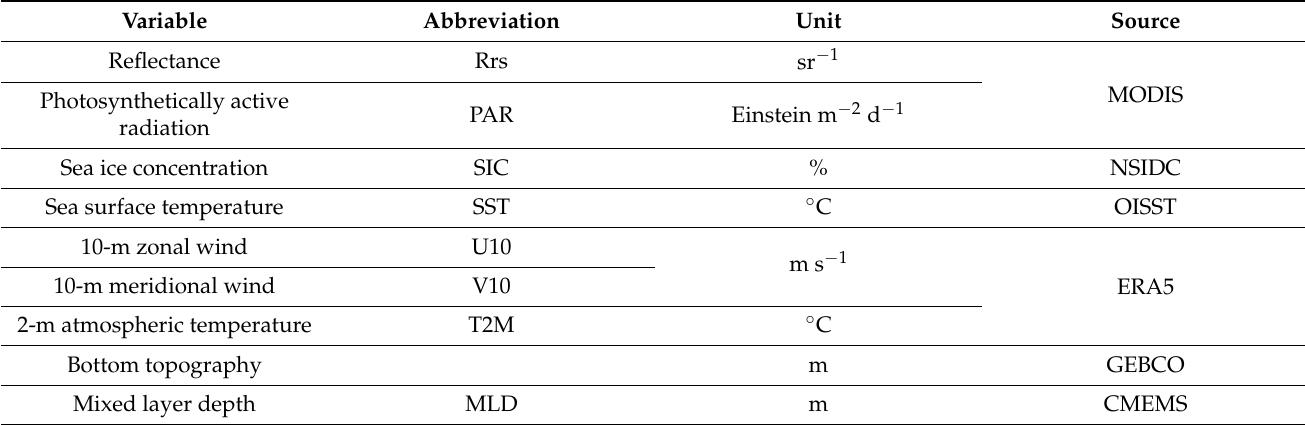
Table 1. Information on the datasets used in this